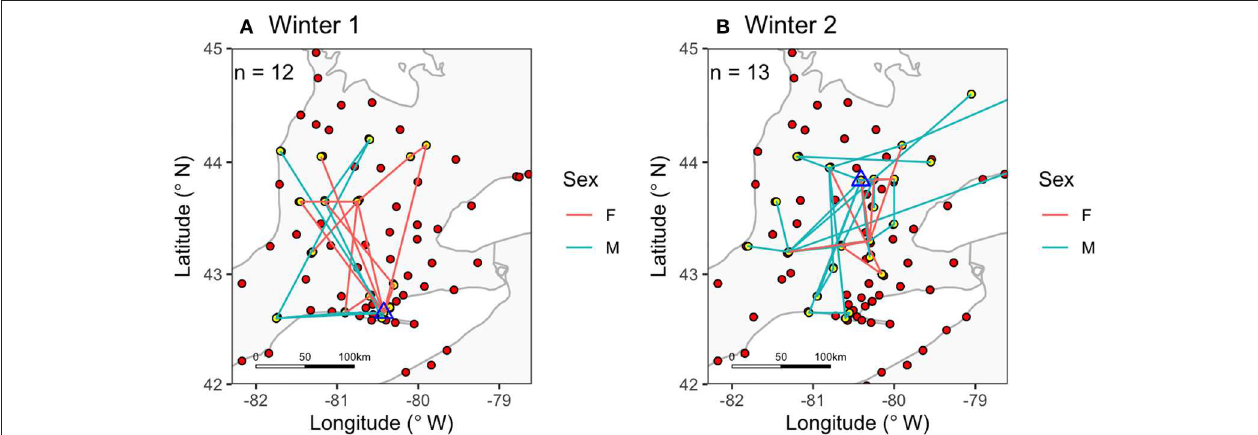
FIGURE 2 | Within-winter movements of snow buntings (A) Winter 1, 2015/2016, and (B) Winter 2, 2016/2017, by using automated radio-telemetry (Motus Wildlife Tracking Network). Red circles show the location of receiver stations and yellow circles show stations where snow buntings were detected; blue triangles indicate deployment sites. Blue (males) and red (females) lines connect detections for individuals.